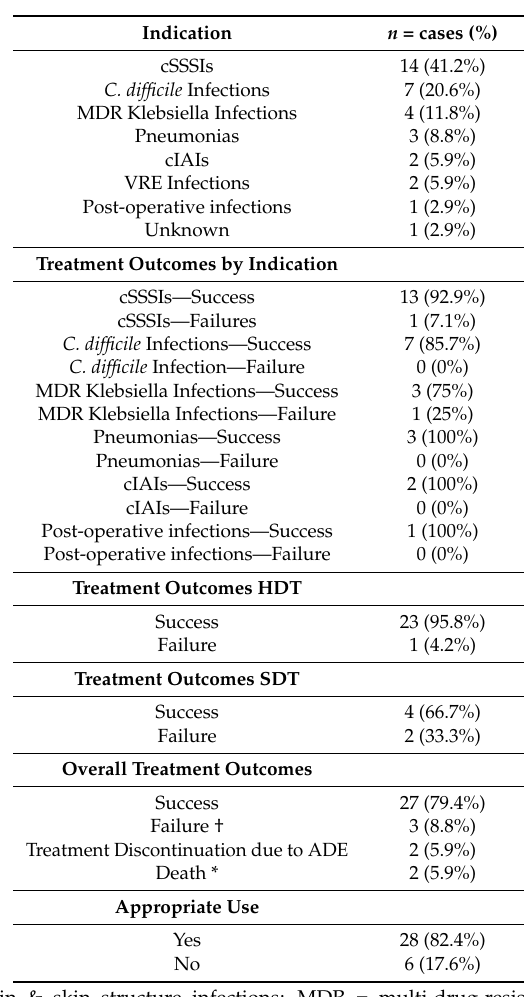
Table 1. Winthrop University Hospital’s recent tigecycline experience: primary